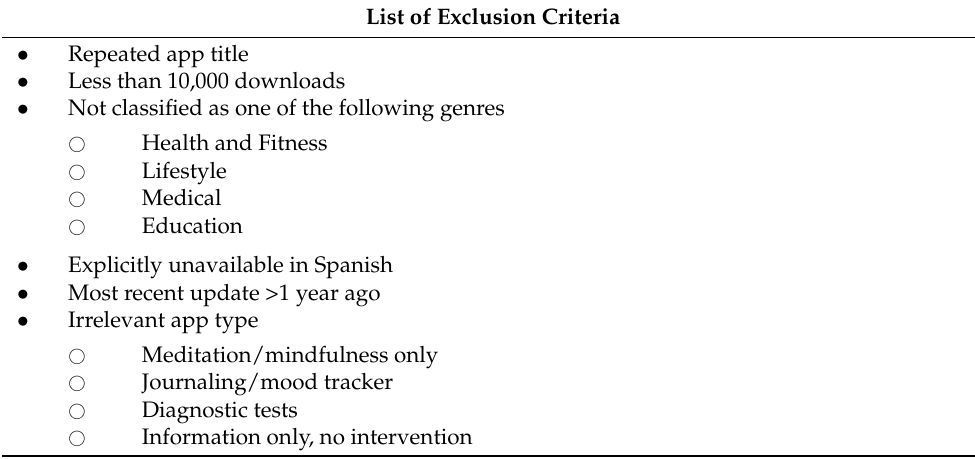
Table 1. Overview of app exclusion criteria.